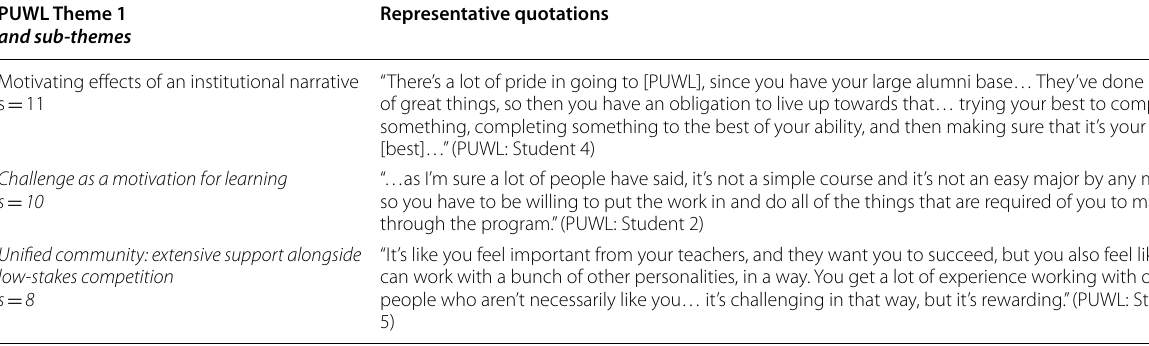
Table 11 PUWL institutional analysis—Theme 1 PUWL Theme 1 and